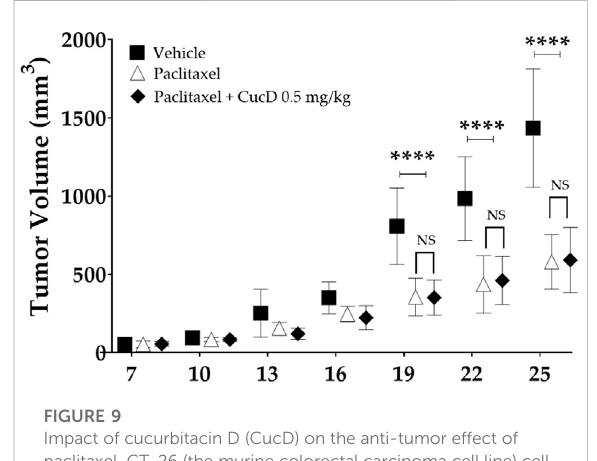
FIGURE 9 Impact of cucurbitacin D (CucD) on the anti-tumor effect of paclitaxel. CT-26 (the murine colorectal carcinoma cell line) cell- implanted mice were treated with paclitaxel (8 mg/kg, i. p.) once a week and CucD (0.5 mg/kg, i. p.), three times a week for 3 weeks. The tumor volumes were calculated as follows: volume (mm 3 ) = ½ (length x width 2 ). Tumor growth was expressed as the mean tumor volume ± SD of independent experiments. N = 6 in each group and **** p < .0001 vs. paclitaxel and paclitaxel + CucD .5 mg/kg with two-way ANOVA, followed by Tukey ’ s post-test for multiple